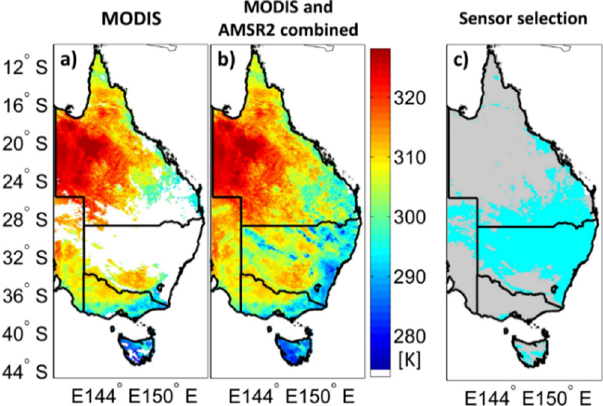
Figure 8. An example of the individual MODIS LST product for 3 April 2015 ( a ); the combined Land Surface Temperature product ( b ) and a spatial map ( c ) that demonstrates the sensors that were used in the combined Land Surface Temperature product. The Land Surface Temperature product in the gray shading is based on MODIS whereas the cyan regions are based on scaled AMSR2 observations.